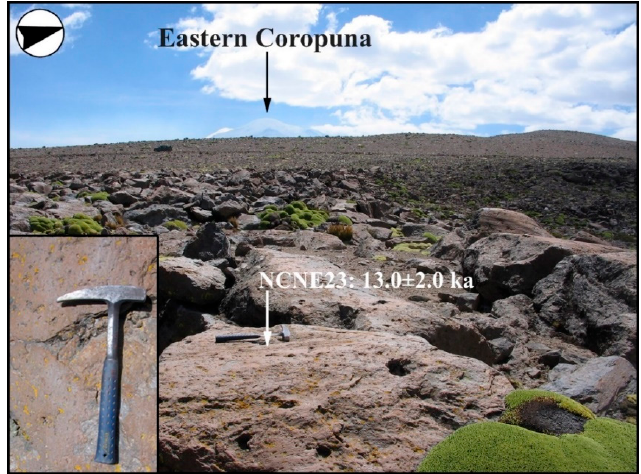
Figure 6. Polished bedrock sampled in Pampa Pucaylla Altiplano, eastward of Coropuna.